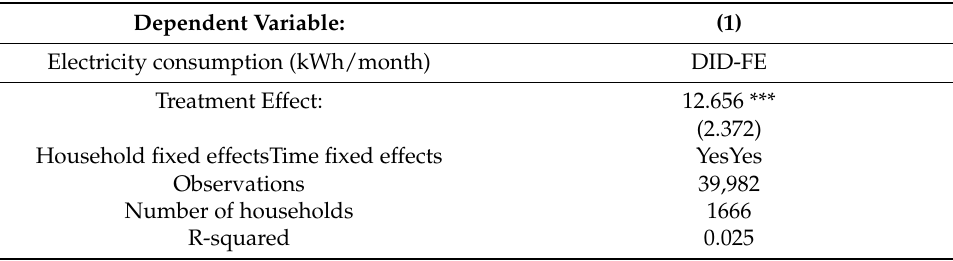
Table 2. Average treatment effect on the energy consumption